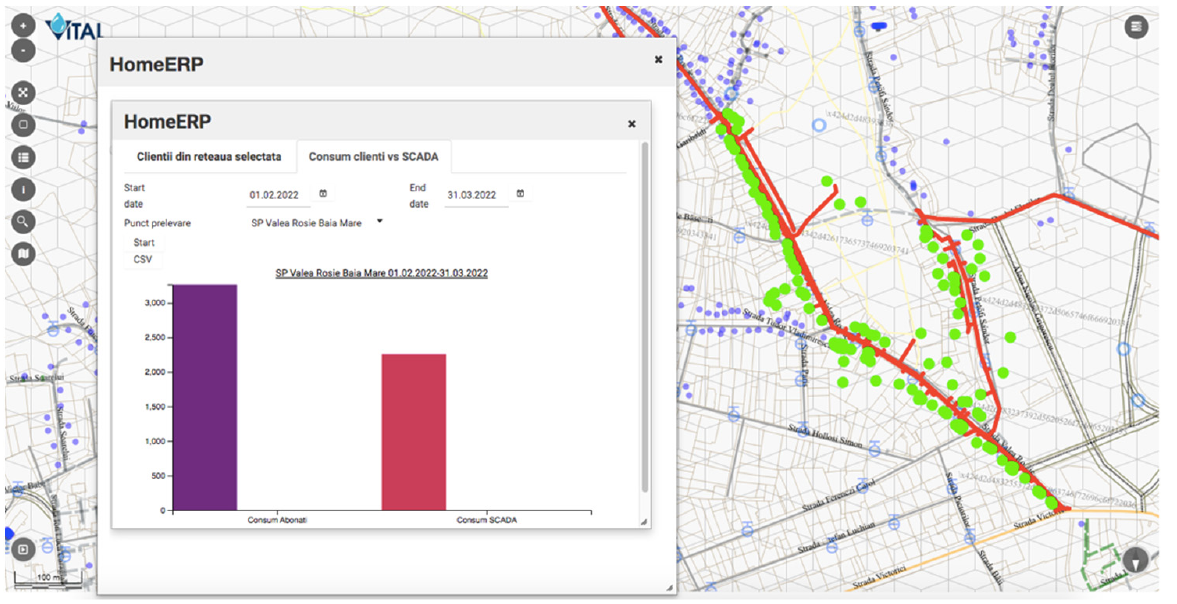
Figure 7. Comparison between invoiced and actual consumption. (The highlighted pipe network has the red color; the clients are the green dots)